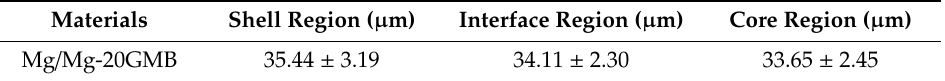
Table 2. The average grain size of as-cast Mg / Mg-20GMB hybrid composite.